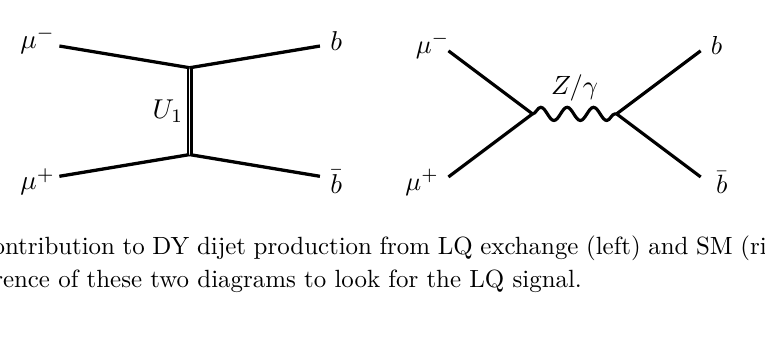
Figure 9 . Contour plots of the 95% CL (dashed) and 5 σ discovery (solid) for single LQ production √ at s = 3 , 14 TeV. We show the reach for flavor scenario 1 with one muon in the final state (left), and flavor scenario 3 with a tau in the final state (right). In the gray region, the LQ lifetime is longer than Λ − 1 and non-perturbative hadronization effects will have to be included for a more QCD accurate result.